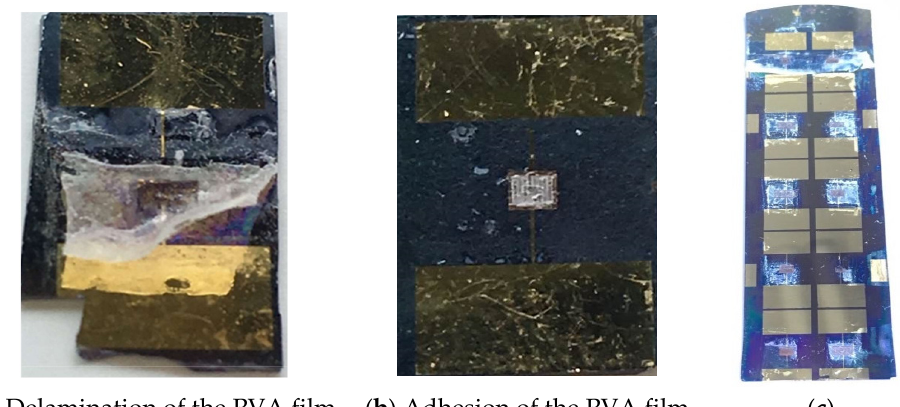
Figure 4. Photographs of microdevices fabricated from ( a ) 10 wt.% aqueous (delamination) and ( b ) 7.5 wt.% PVA solutions. ( c ) Photograph of 10 microdevices fabricated on the same substrate, top view.